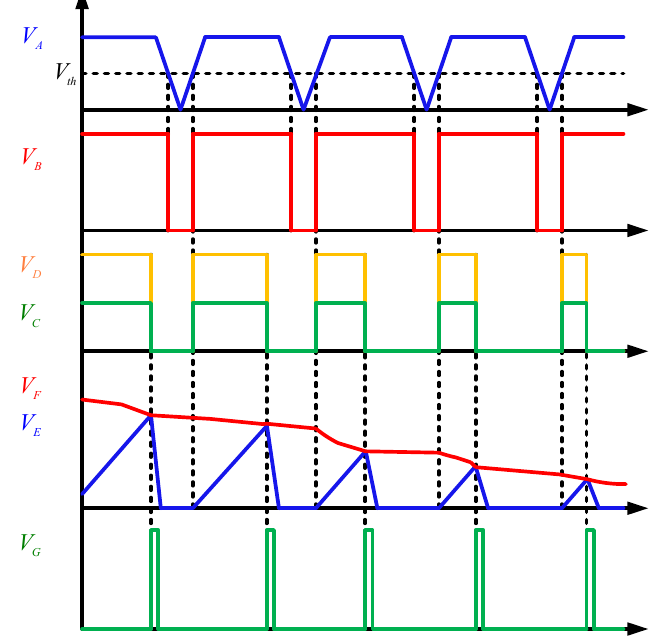
Figure 21. Principle waveforms of auxiliary control